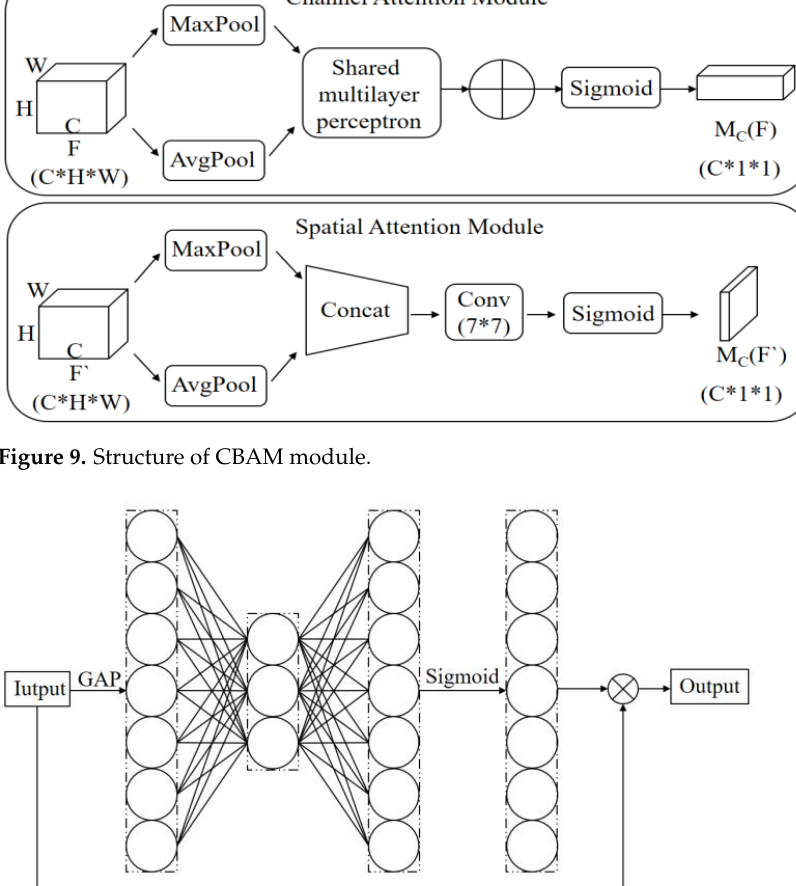
Figure 10. Structure of SE module.